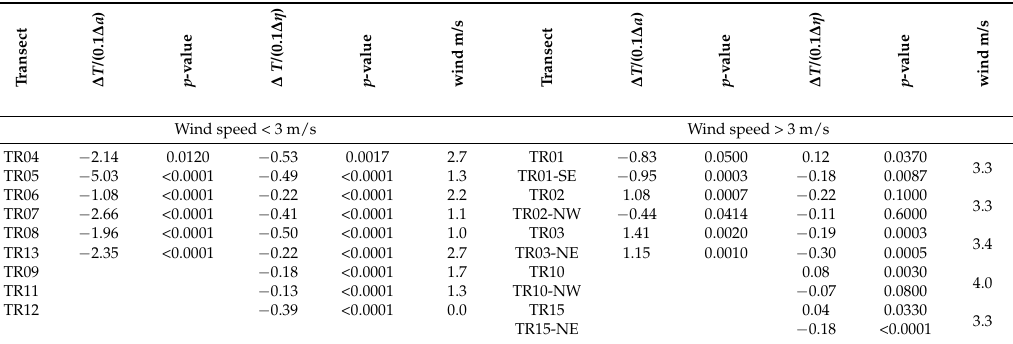
Table 5. Correlations between air temperature ( ◦ C) (observed from transects) and neighborhood-scale (500 m) albedo and/or canopy cover. Transects with wind direction represent effects from a 1-km upwind